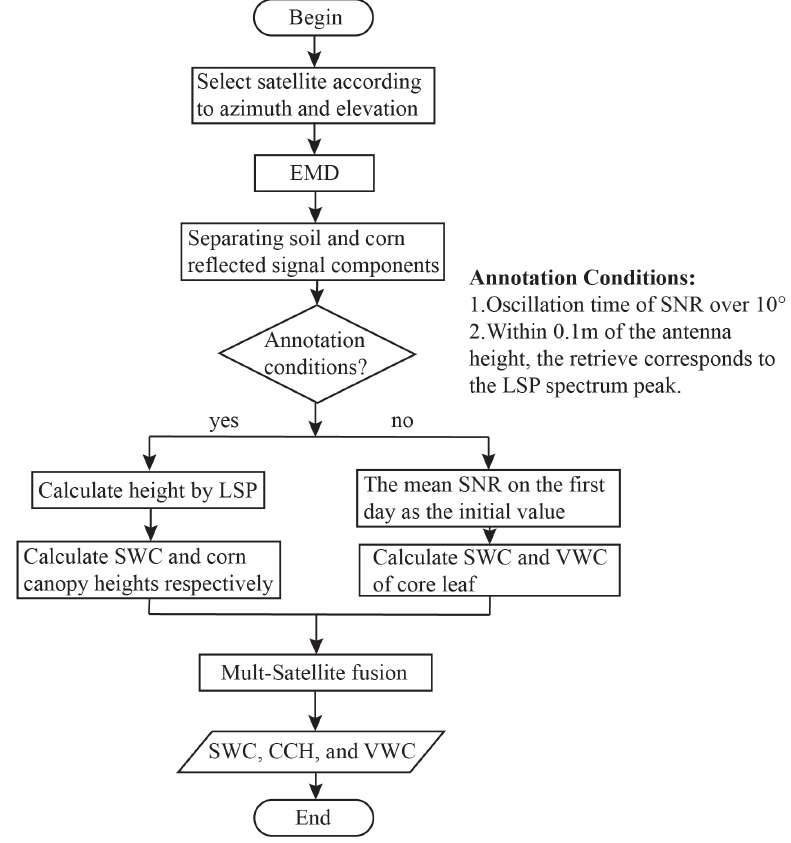
Figure 4. Flow of the algorithm proposed in this